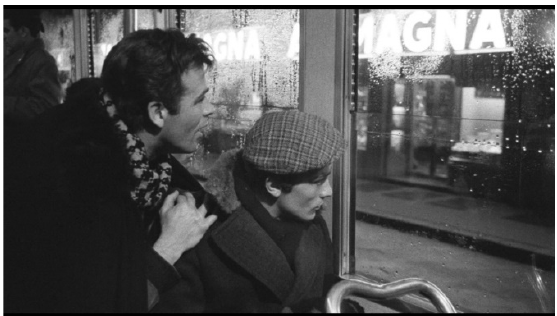
Figure 6 Screenshot from Rocco and His Brothers. (Goffredo Lombardo.)